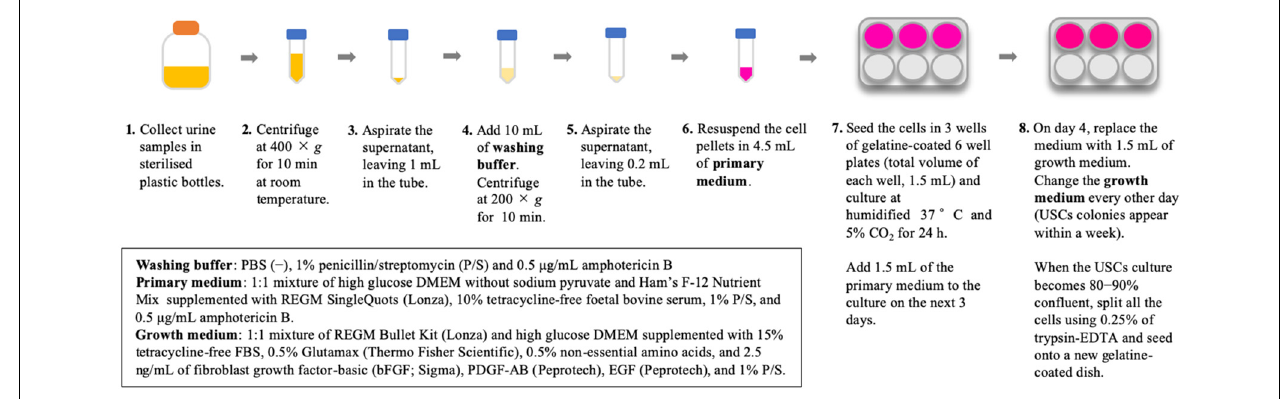
FIGURE 1 | Method for isolation of urine-derived stem cells